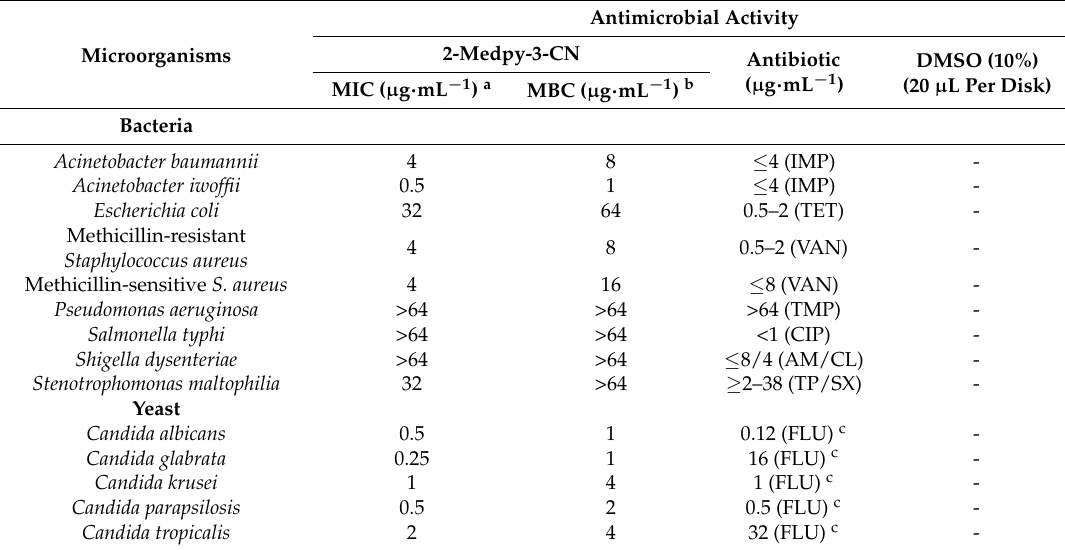
Table 5. Minimum inhibitory concentration (MIC), minimum bactericidal concentration (MBC), and minimum fungicidal concentration (MFC) determinations of 2-Medpy-3-CN against human pathogenic bacteria and Candida spp. DMSO—dimethyl